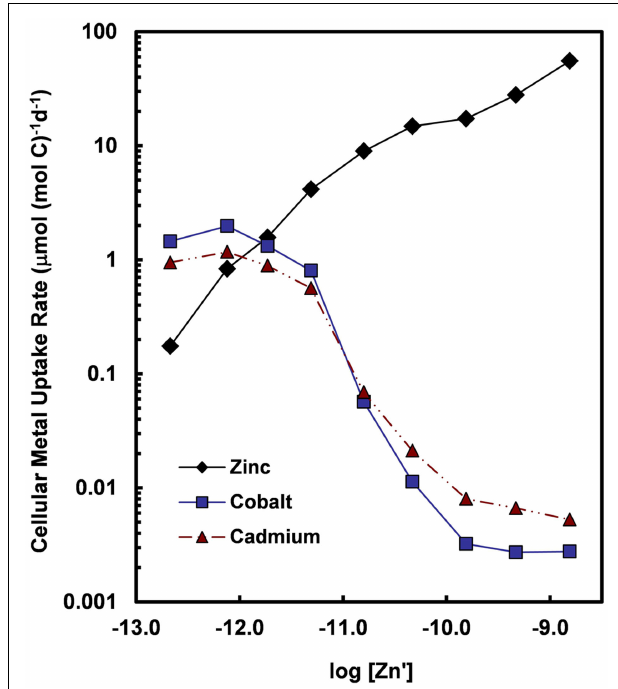
FIGURE 7 | Cellular uptake rates for Zn, Co, and Cd (normalized per mol of cell carbon) for the oceanic diatom Thalassiosira oceanica plotted as a function of the log 10 of the molar concentration of dissolved inorganic zinc species (Zn (cid:2) ). Concentrations of Cd (cid:2) and Co (cid:2) were held constant at 2.7 and 1.5pM, respectively, within the range of values for near-surface ocean water (Bruland, 1992; Saito et al., 2004). Uptake rates for Cd and Co increase by at least two orders of magnitude when Zn (cid:2) concentrations decrease below 10 − 10 M.The large increase in uptake rates reflect the induction of a high-affinity cellular transport system (or systems) for Cd and Co in response to declining intracellular Zn levels or transport of the two metals into the cell by an inducible high-affinity Zn transport system. Data are from Sunda and Huntsman